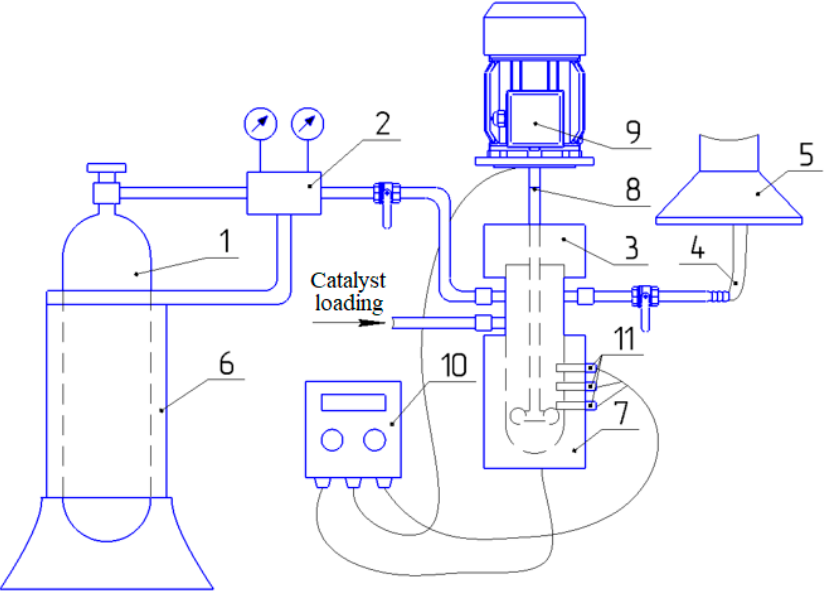
Figure 2. Flow diagram of an experimental pyrolysis unit for organic products, where: 1—feed gas cylinder; 2—control and feed gas system; 3—pyrolysis reactor; 4—air duct; 5—extractor hood; 6— thermostatic volume; 7—electric furnace; 8—stirrer; 9—electric motor; 10—meter-controller; 11— thermocouple.